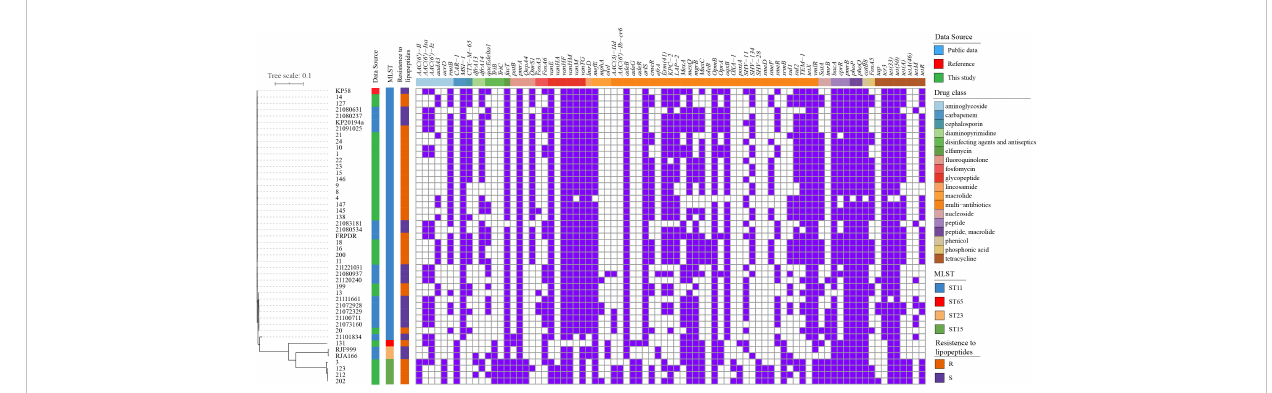
FIGURE 2 Phylogenetic tree and distribution of resistance genes of K. pneumoniae isolates (A) core-genome-based ML phylogenetic tree showing the relationship of 30 polymyxin-resistant and 17 polymyxin-sensitive K. pneumoniae isolates constructed taking KP58 as the reference. Apart from 28 strains sequenced in this study, the other 19 genomes were obtained from public data. The antibiotic- resistant genes were mapped on the right, with carried genes painted in purple and classi fi ed according to the ResFinder database.